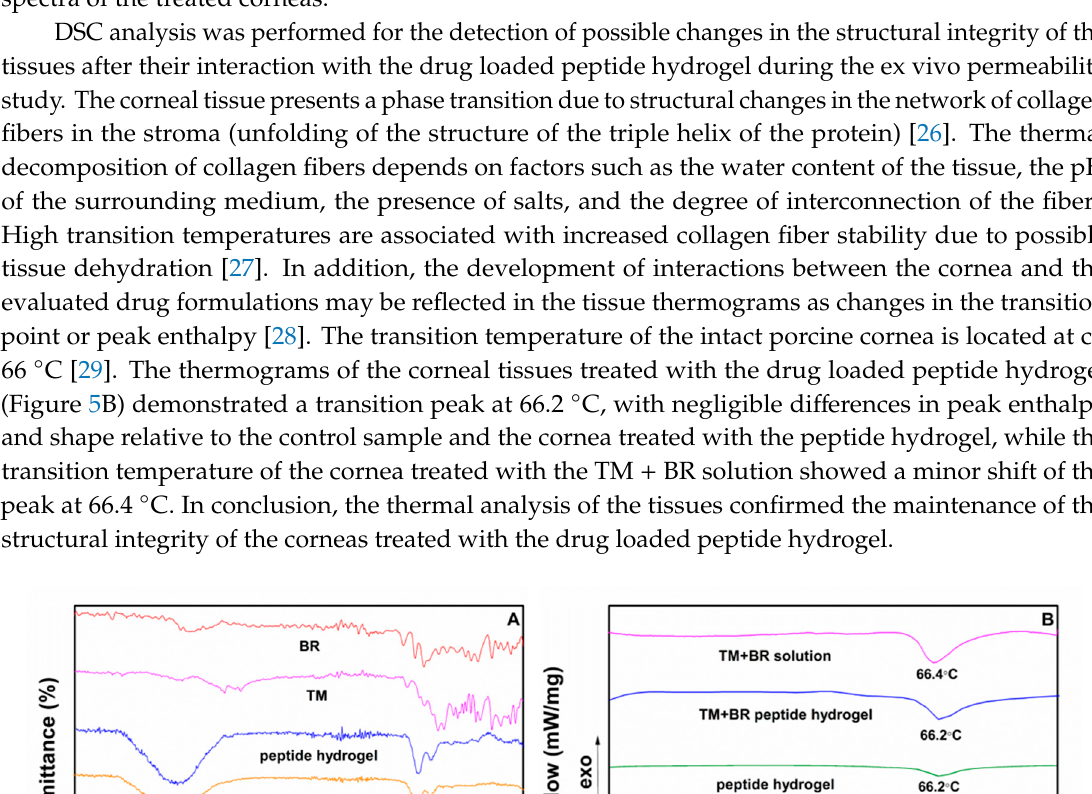
Table 3. Hydration content values of the corneas at the end of the ex vivo permeability study.